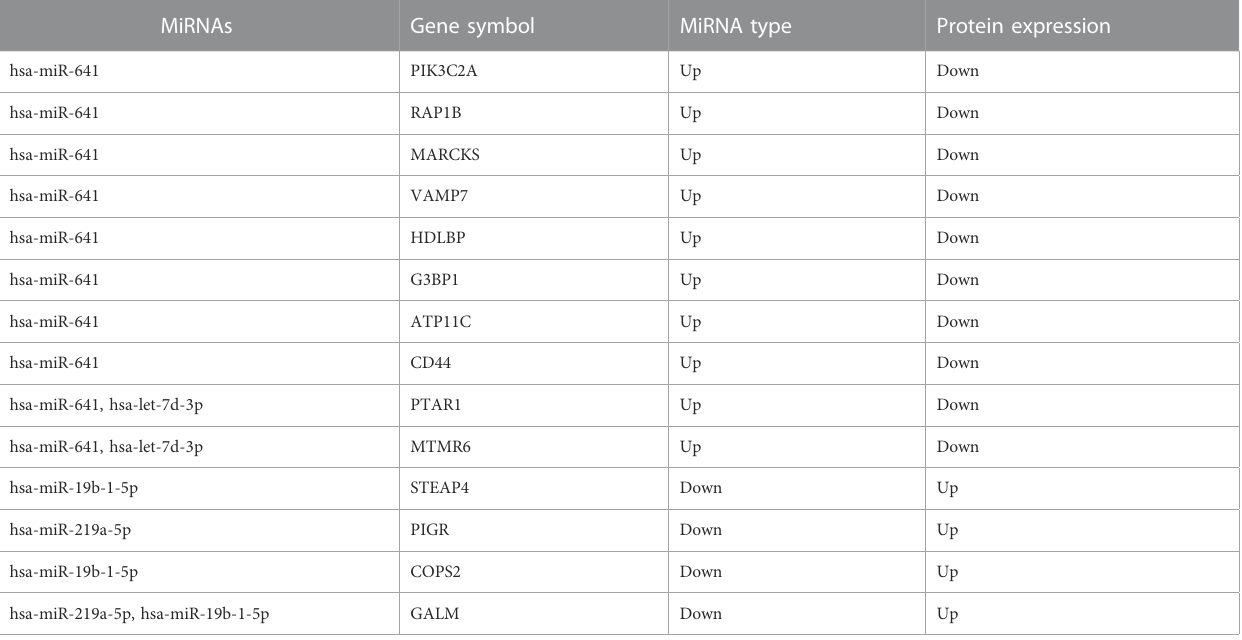
TABLE 2 Interaction analysis of target mRNAs of differential miRNAs and proteins.